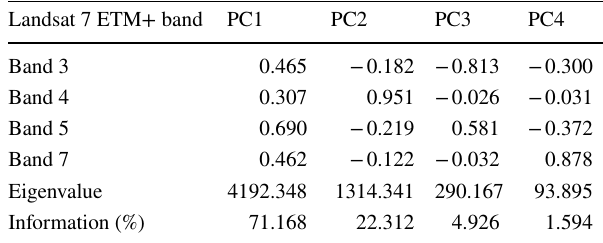
Table 3 Eigenvector and eigenvalues of PCA on band 3, 4, 5 and